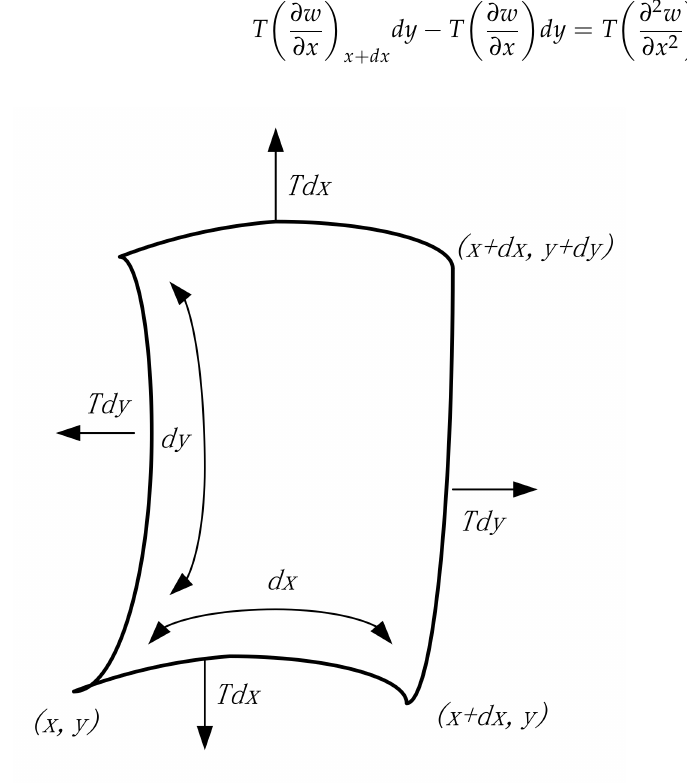
Figure 3. Forces during transverse vibration of the unitary